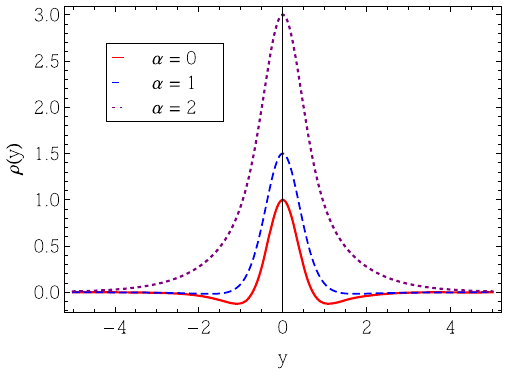
Fig. 4 Energy density ρ( y ) with φ 0 = k = 1 for different values of α